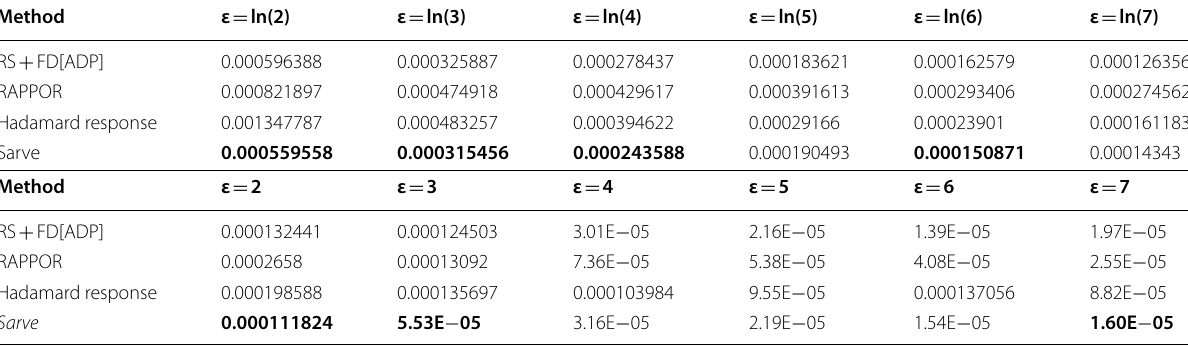
The values in bold indicate privacy conditions when Sarve performed better than adaptive RS estimated